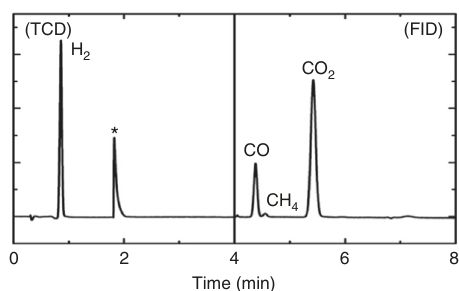
Fig. 6 The gas chromatogram of the gas from laser irradiation of MWCNT suspension in methanol (* = from equipment disturbance caused by pressure fl uctuation due to switching of injection valves). TCD,